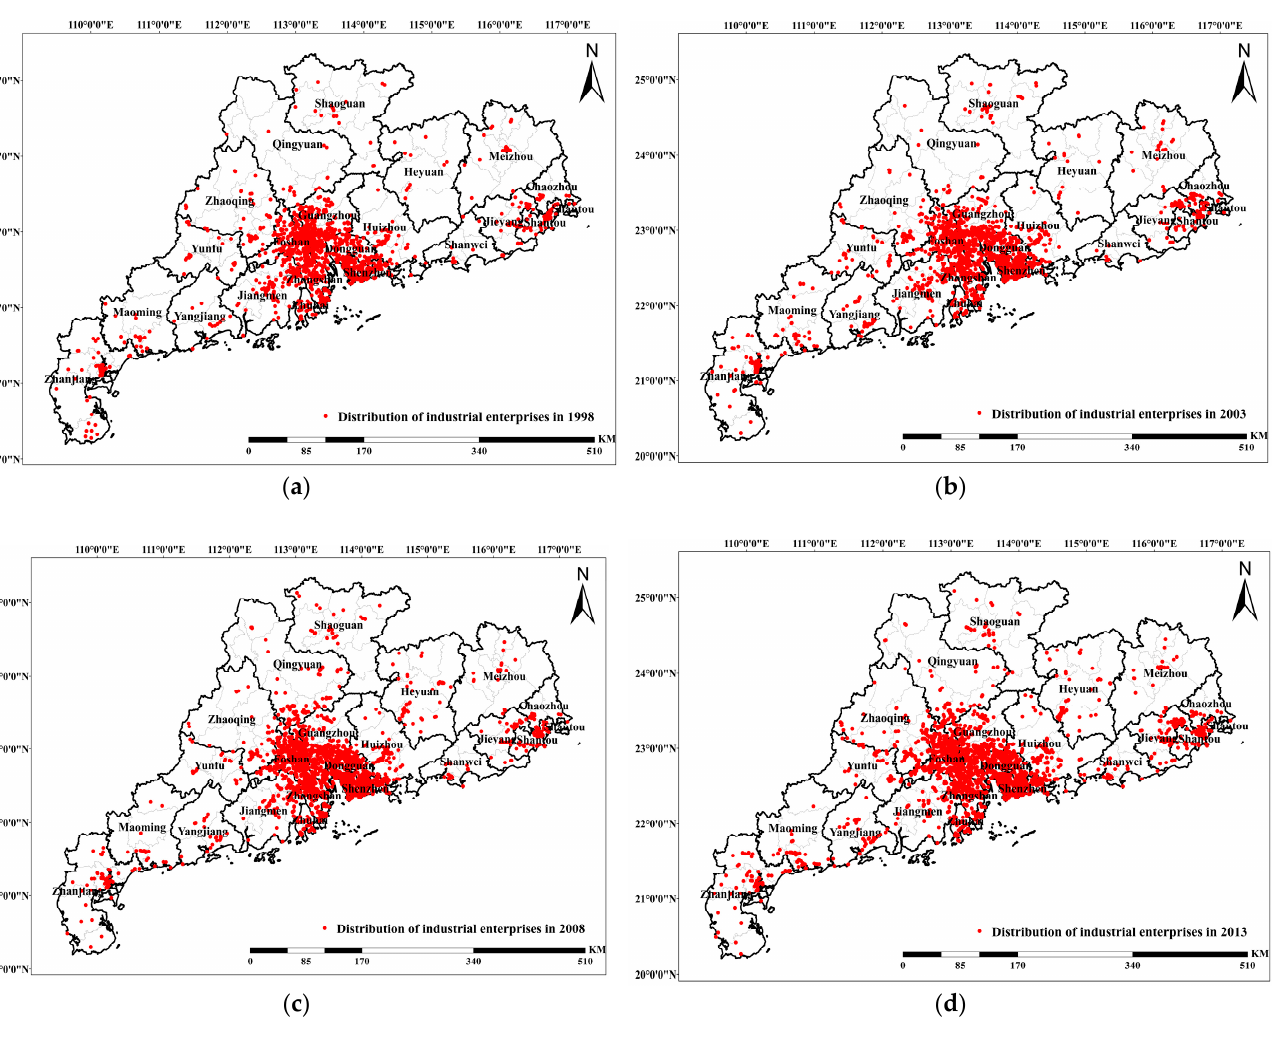
Figure 3. Change Chart of the Number of Industrial Enterprises in Guangdong. ( a ) 1998; ( b ) 2003; ( c ) 2008; ( d ) 2013.